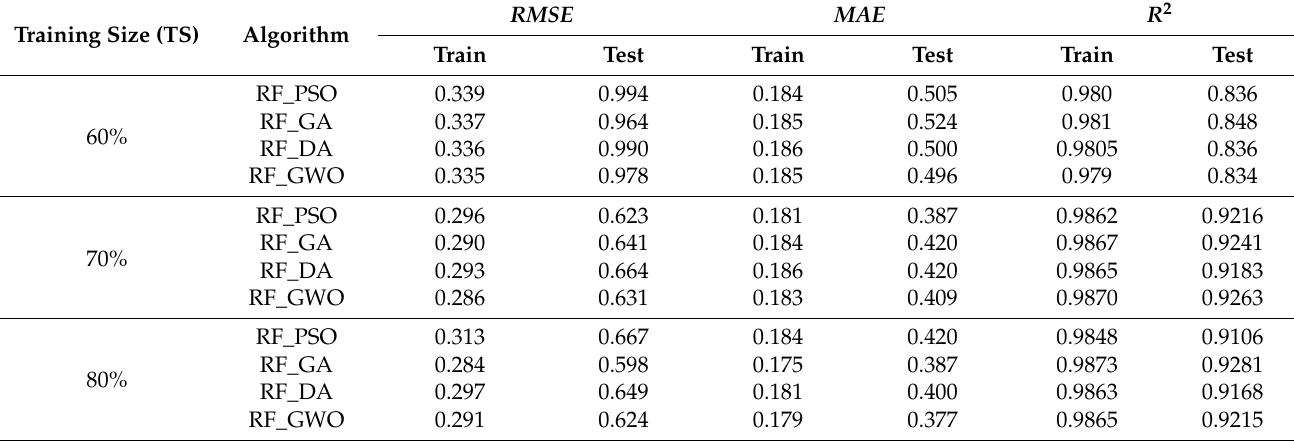
Table 6. The three criteria of RMSE, MAE, and R 2 in various training dataset sizes